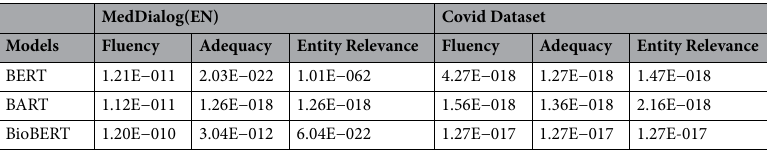
Table 9. Results of statistical significance test for human evaluation